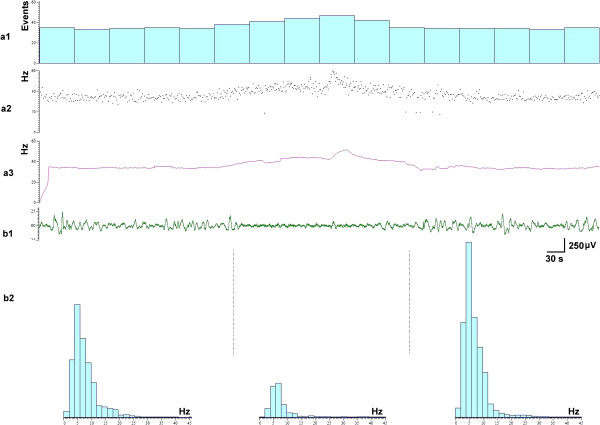
Relationship between the firing of the NTS neurons and the epileptiform activity in EEG traces. (a1-3) The discharges of the NTS neurons, (a1) Rates, (a2) Instantaneous frequency, (a3) Mean frequency. (b1) Epileptiform activity in EEG traces. (b2) Difference of spectral pattern of EEG when seizure off (left, right) or seizure on (middle).